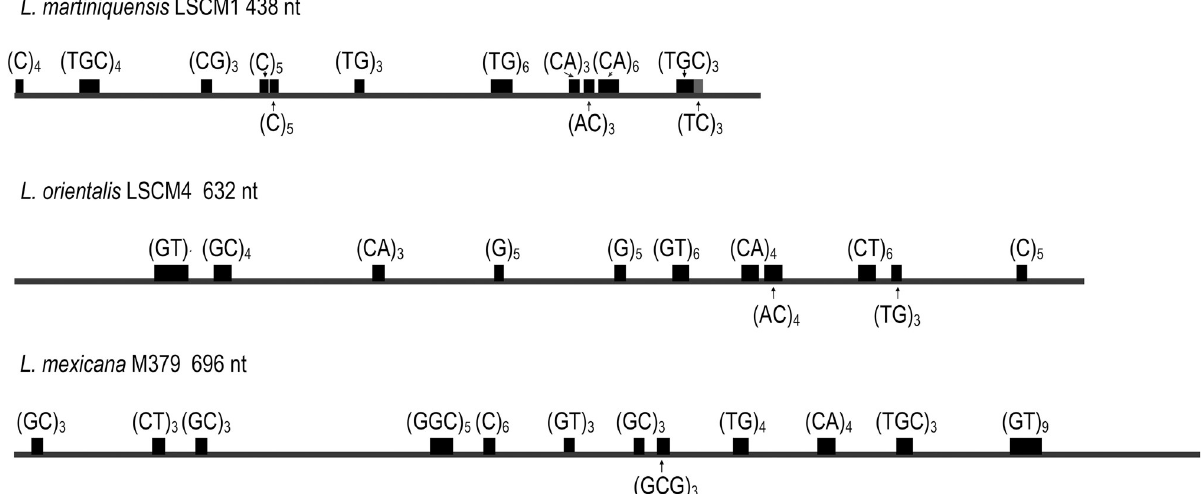
Fig 3. Microsatellite distribution in 3’-UTR of HSP70-I genes of L . martiniquensis , L . orientalis , and L . mexicana . The repeated motifs correspond to those found in the sense strand. Note that the drawing scale is not proportional for the different Leishmania species. https://doi.org/10.1371/journal.pntd.0009982.g003 Different PCR-RFLP patterns of digested 3 0 -UTR of HSP70-I amplicons with Bsu RI were obtained for L . martiniquensis , L . orientalis , L . braziliensis , L . guyanensis = L . panamensis , L . mexicana = L . aethiopica = L . tropica , L . amazonensis , L . donovani = L . infantum , and L . major (Fig 4 and Table 1). The PCR-RFLP patterns of L . guyanensis (M4147) and L . panamensis (LS94) were similar and one extra band ( > 500 bp) was observed differentially from the in silico predicted patterns. Results also confirm that L . mexicana , L . aethiopica and L . tropica had simi- lar PCR-RFLP patterns (Fig 4 and Table 1). Likewise, L . donovani and L . infantum had similar